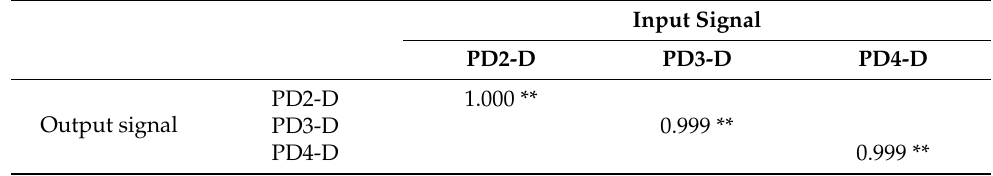
Table 5. Pearson’s correlation coefficient between I/O signals of the